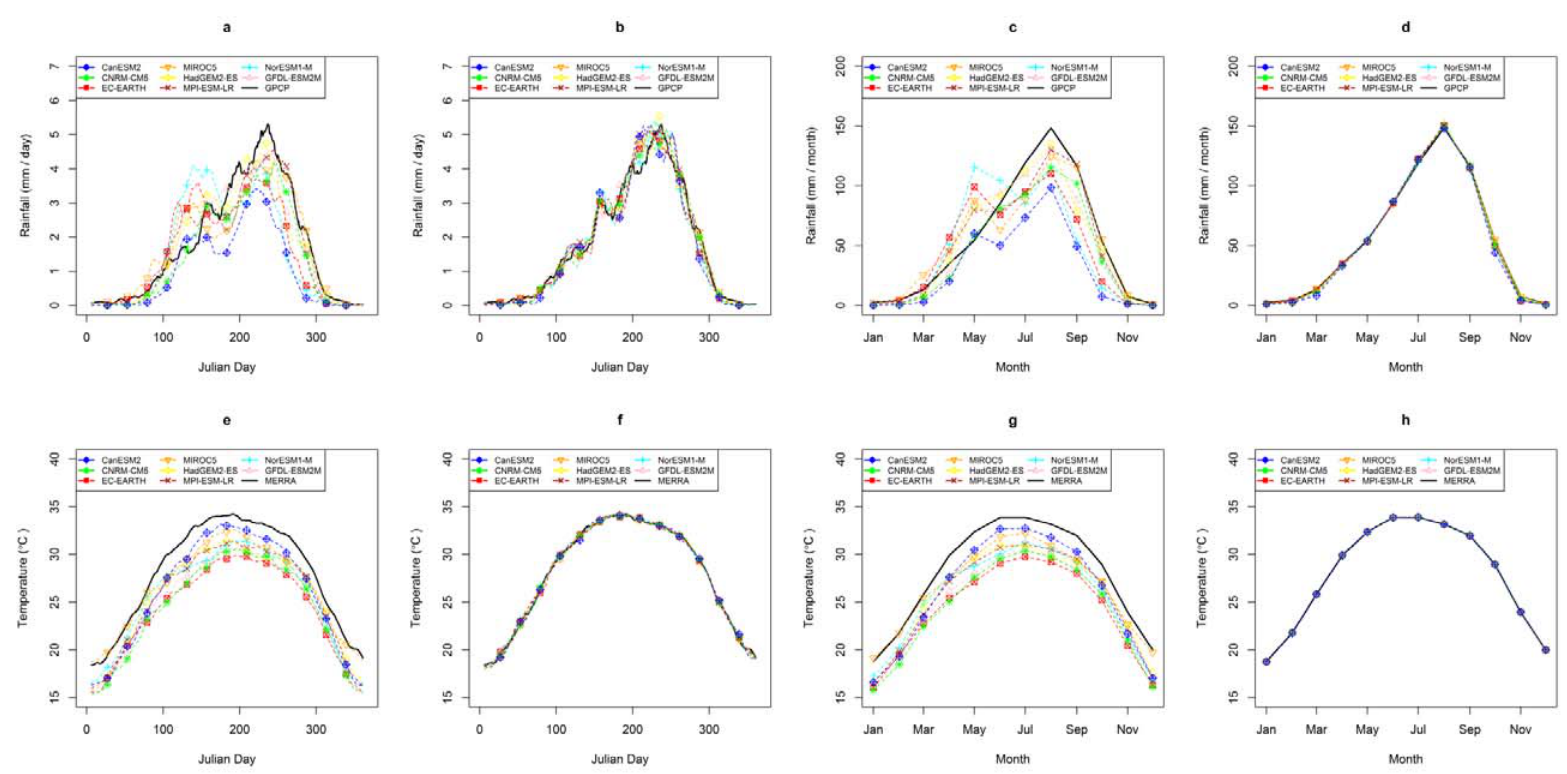
Figure 3. Comparison of CMIP5 rainfall and temperature simulations with GPCP and MERRA before and after bias correction for the evaluation period (1997–2010). ( a ) Climatological (daily mean from 1997–2010) rainfall before bias correction; ( b ) climatological rainfall after bias correction; ( c ) monthly mean rainfall before bias correction; ( d ) monthly mean rainfall after bias correction; ( e ) climatological temperature before bias correction; ( f ) climatological temperature after bias correction; ( g ) monthly mean temperature before bias correction; ( h ) monthly mean temperature after bias correction.